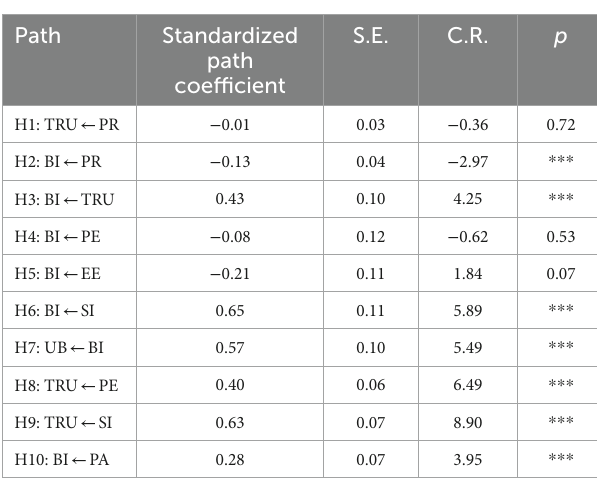
TABLE 4 Hypotheses testing